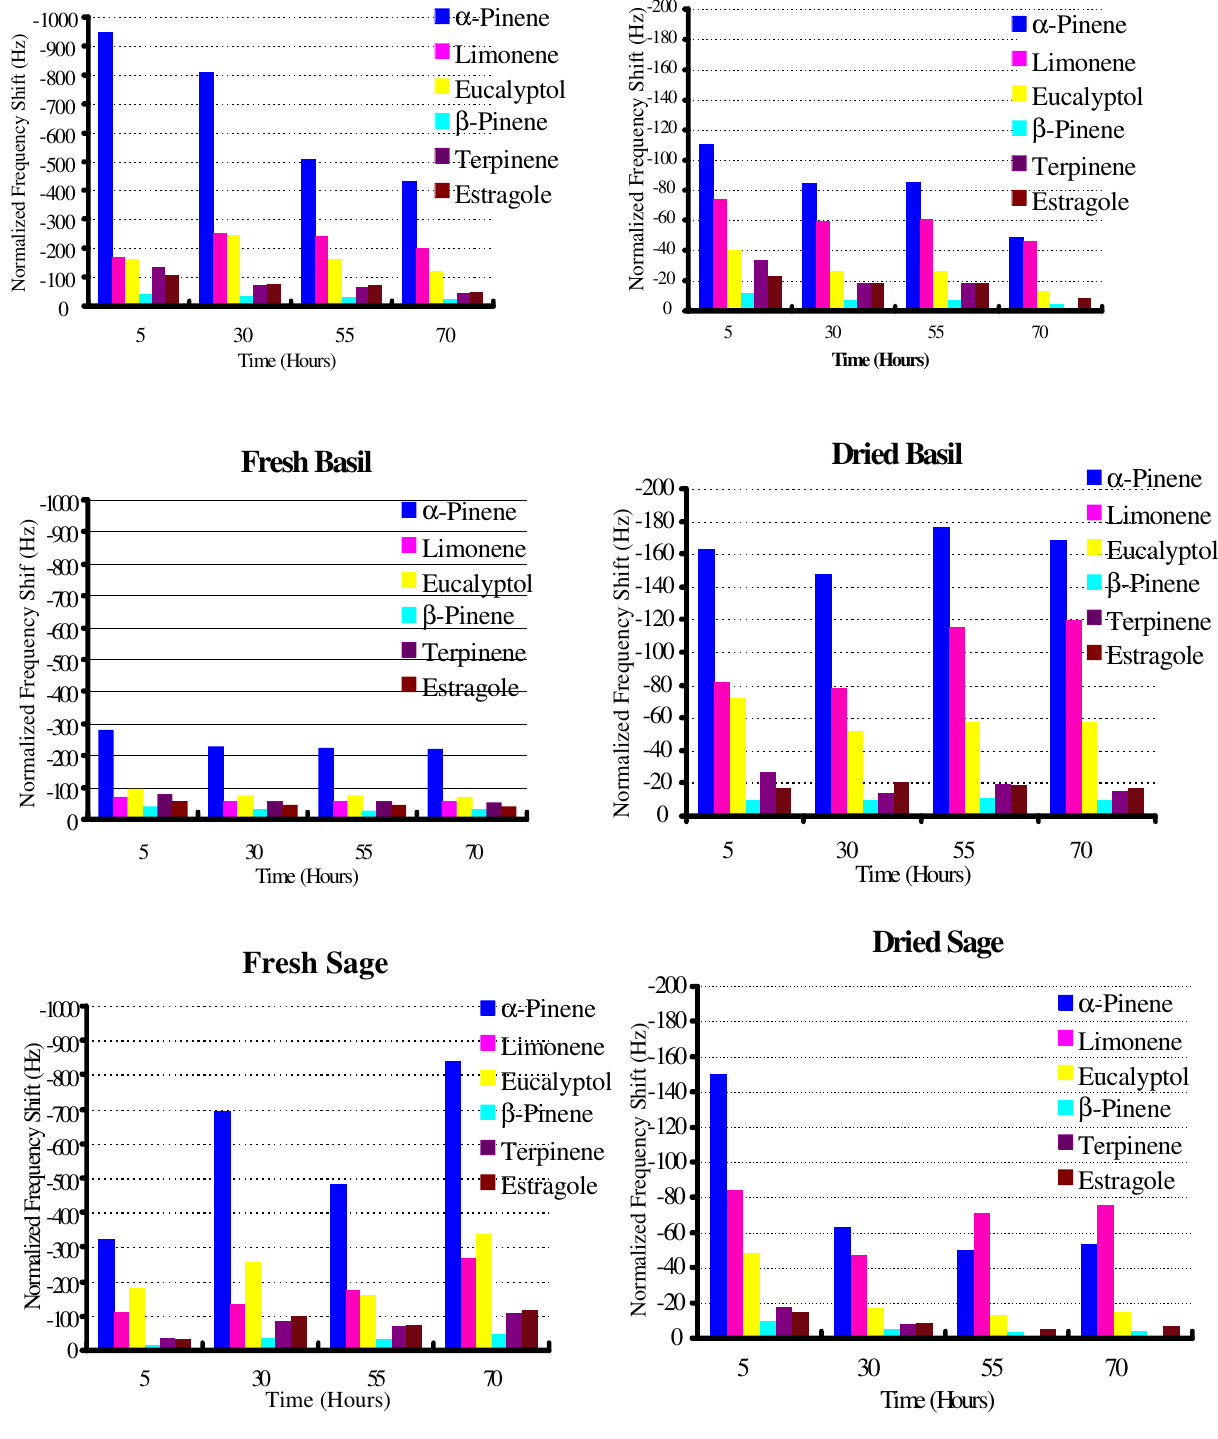
Figure 5. Terpene emanation patterns from fresh and dried